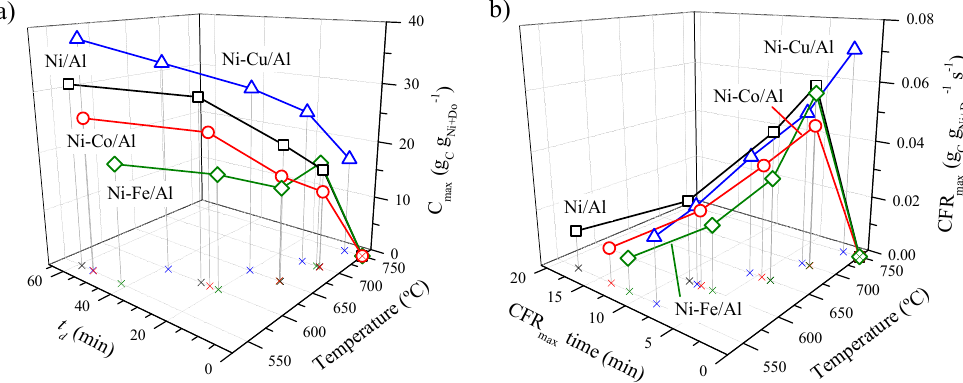
Figure 4. ( a ) Accumulated carbon (expressed as g C g Ni+Do − 1 ) until the catalyst deactivation; and ( b ) maximum CFR , both as a function of time ( t d and time to CFR max ) and operating temperature. Catalytic decomposition of methane (CDM) carried out in a quartz FBR (fixed-bed reactor) for 120 min with an operating temperature of 650 ◦